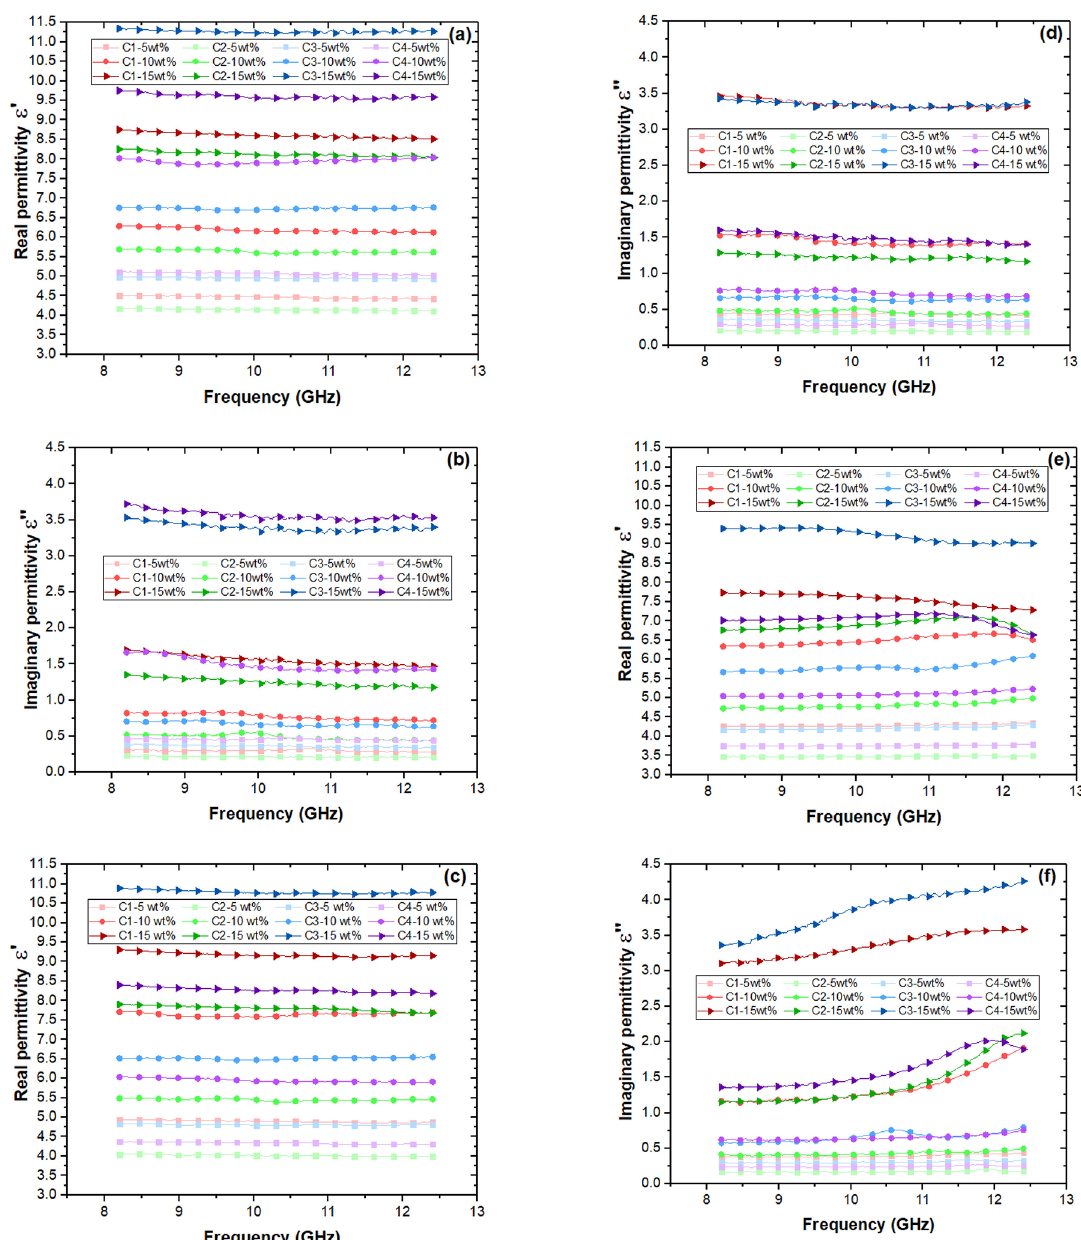
Figure 4. Complex permittivity for each DUT (a, b) without FSS, (c, d) with FSS of 2.0 mm diameter holes and (e, f) with FSS of 5.0 mm diameter holes. FSS panel in free space. Thus, real and imaginary dielectric properties for the first set of DUTs with FSS structure (2.0 mm diameter) are presented in Figures 4(c) and 4(d), respectively. The highest real permittivity value is also for sample using C3-15wt%. However, the second highest permittivity value is for sample C1-15wt%, while for composites without FSS is for C4-15wt%. Since samples have the same material and are exclusively differentiated by the FSS geometry, the change of C1 results by C4 is a clear effect of FSS